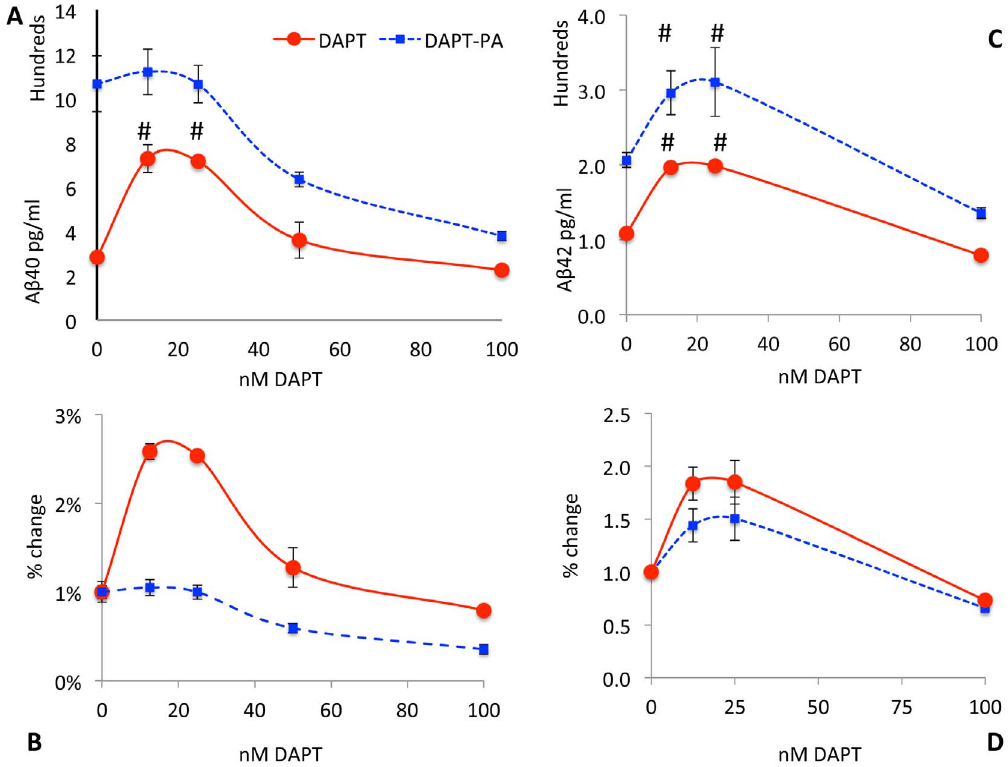
Figure 4. PA treatment mitigates A b stimulation. SH-SY5Y cells were treated with a combination of PA and DAPT (Blue squares and dashed lines) or DAPT alone (Red circles, continuous line) and A b 40 (A) or A b 42 (C) were plotted as raw data in pg/ml or as percent change (C, D). The change from the 0 DAPT control show that stimulation by low level GSI treatment is completely blocked by PA treatment for A b 40 (B) but remained at 1.4 fold for A b 42 (D). Nevertheless, the DAPT-induced stimulation of A b 42 at 12.5 and 25 nM was also significantly (p=0.03) attenuated (C, D). The DAPT- mediated stimulation in PA-treated cells is 4-fold for A b 40 compared to two fold for A b 42, suggesting that ECE contributes more substantially to A b 40 turnover than A b 42, but DAPT increases A b 42 equally by avoiding other unidentified degrading enzymes by the same mechanism.